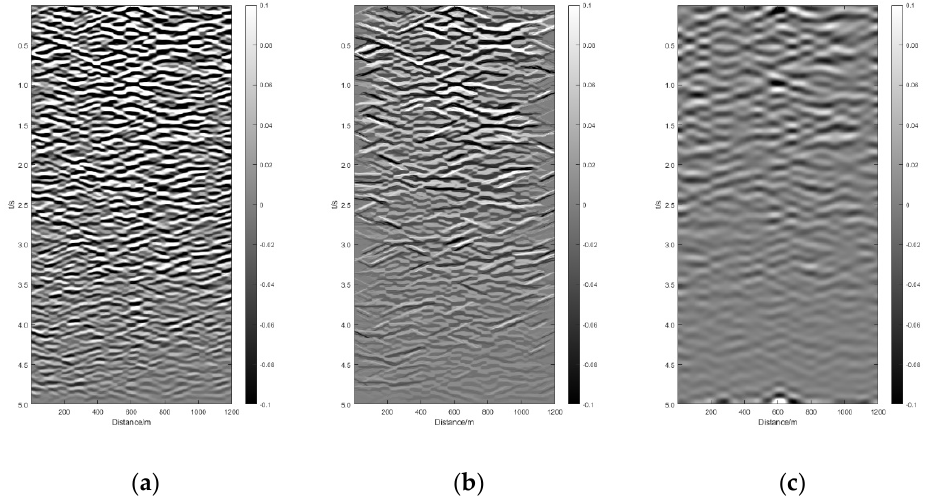
Figure 5. Two conventional methods process the results. ( a ) Small filter window median filter pro- cessing result; ( b ) large filter window median filter processing result; ( c ) f ‐ k filtering processing re ‐ sult.